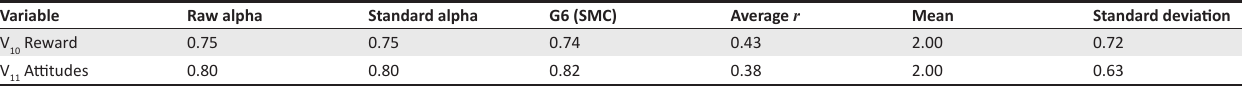
TABLE 11: Density graph of reliability analysis of reward and attitudes.